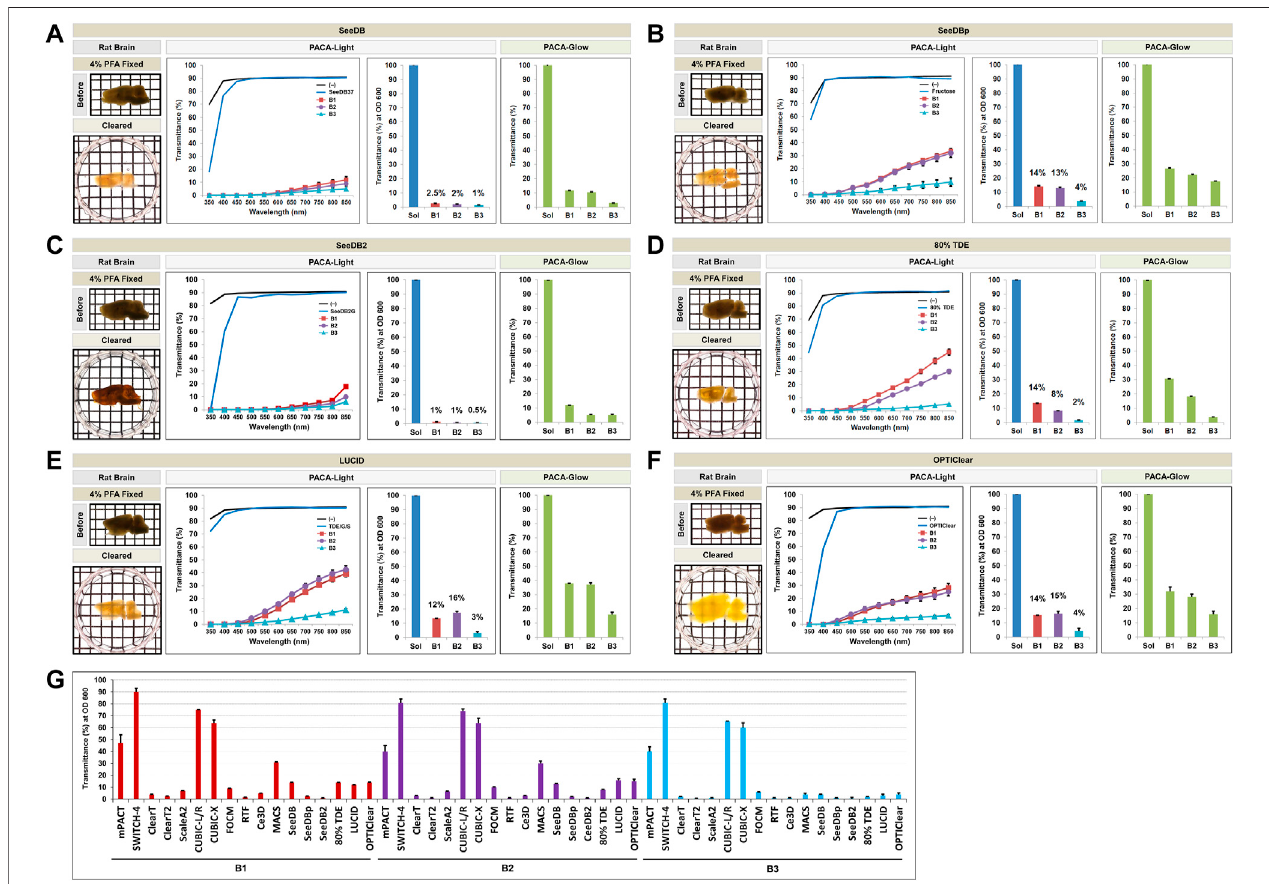
FIGURE 5 | Comparison of tissue clearing achieved with six hydrophilic tissue clearing methods. Comparison of clearing ef fi cacies of SeeDB (A) , SeeDBp (B) , SeeDB2 (C) , 80% TDE (D) , LUCID (E) , and OPTIClear (F) on rat brain samples (3 mm thickness) with both PACA-Light and PACA-Glow. All tissue clearing time course are shown in Supplementary Figures S6, S7 . Optical images showing samples after clearing (red dotted line), along with any changes in sample size upon tissue processing,areincluded(seealso SupplementaryFigureS12 ). (G) Comparisonofclearingef fi caciesofsixteenhydrophilictissueclearing.Threediscsfromthree distinct brain regions (B1: prefrontal cortex and basal ganglia, B2: cerebral cortex and midbrain/diencephalon, B3: cerebellum) were generated and analyzed for each sample. Each color line and bar point to assessment values of empty (black) and refractive index matching solution (blue) of each protocol, and three distinct regions of thebraintheB1(square,red),B2(diamond,violet),andB3(triangle,skyblue).Greenbarspointtoassessmentvaluesoftheglowlight(unit)inthedark.Resultsrepresent three replicates of each experiment, and data are presented as the mean ± SD (standard deviation). The transparency of the cleared brain was evident against a patterned background (length:width (cid:1) 5 mm:5